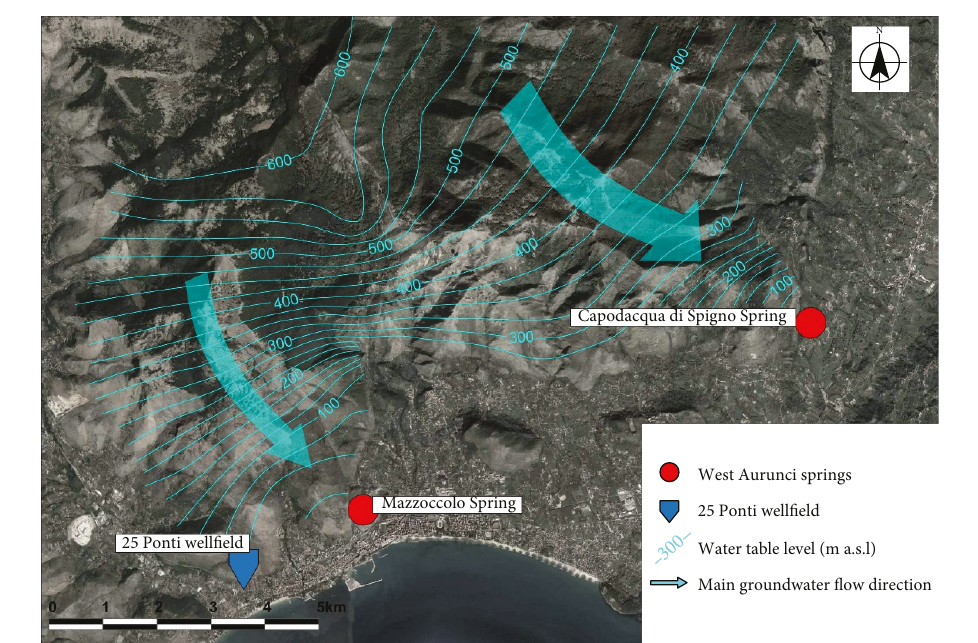
Figure 3: Subsurface hydrology of the West Aurunci karst aquifer (modi fi ed from